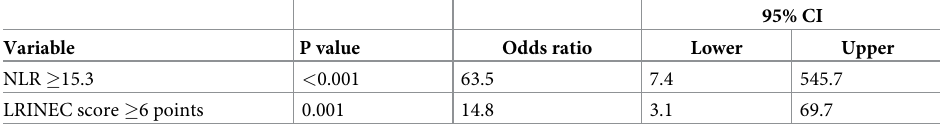
Table 4. The results of the multivariate logistic regression analysis of the risk factors for OCNF in OCSI